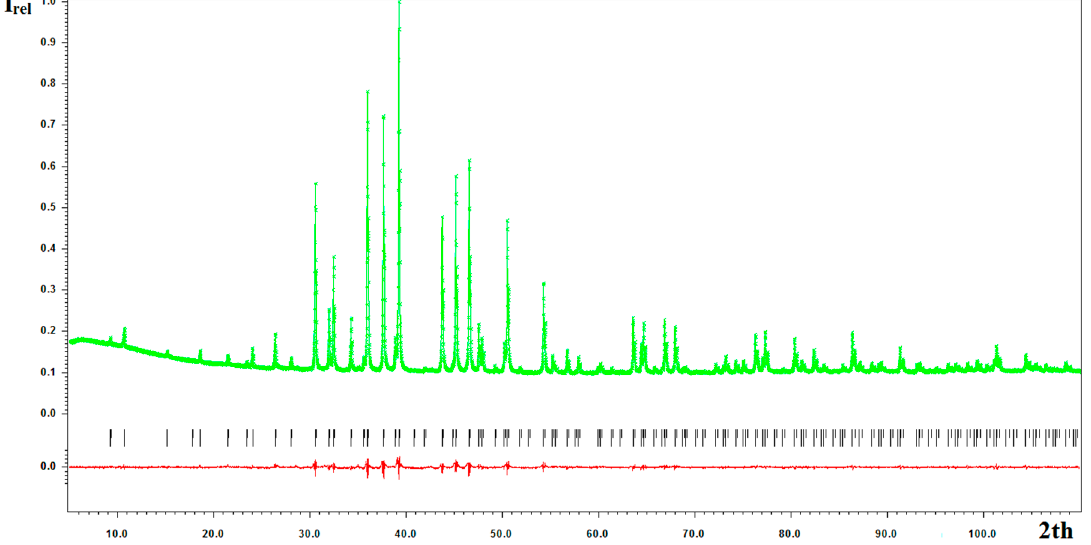
Figure 7. The Rietveld refinement plot for Eu 7 Cu 36 Ni 8 As 23 . Experimental profile, green; peak positions, black; differential profile, red.